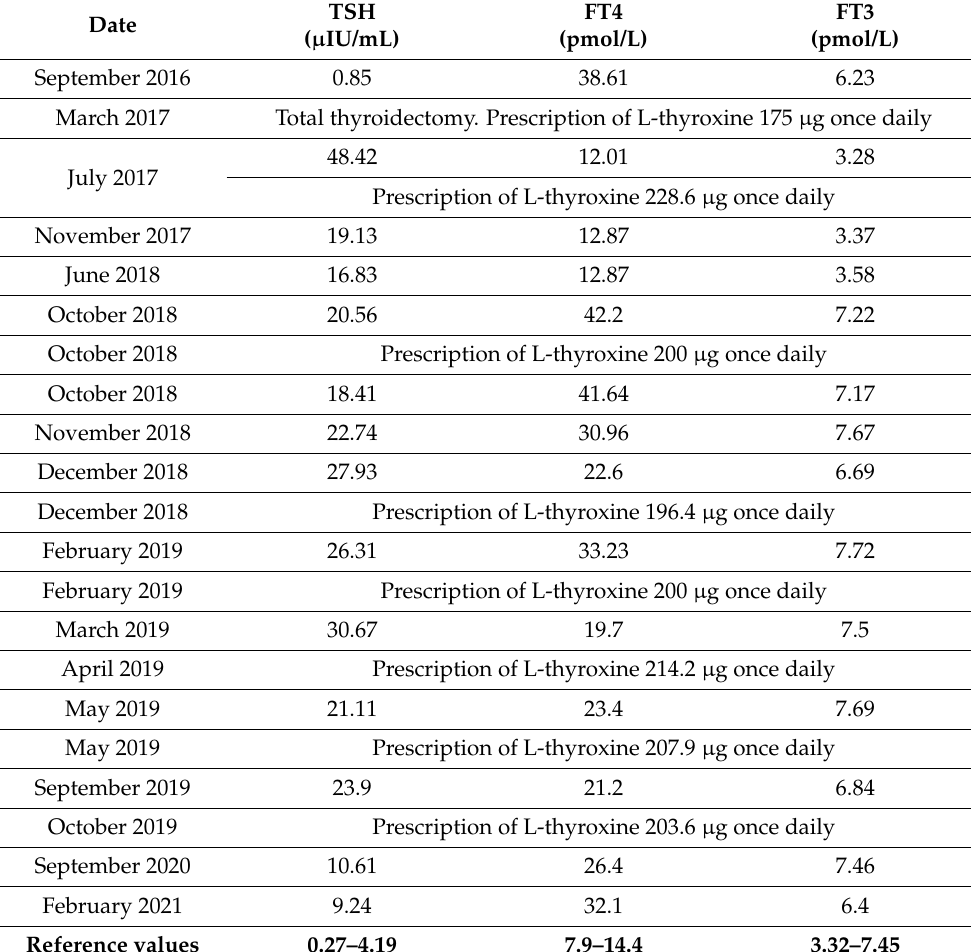
Table 1. Hormone serum levels and posology of L-thyroxine replacement therapy in Patient